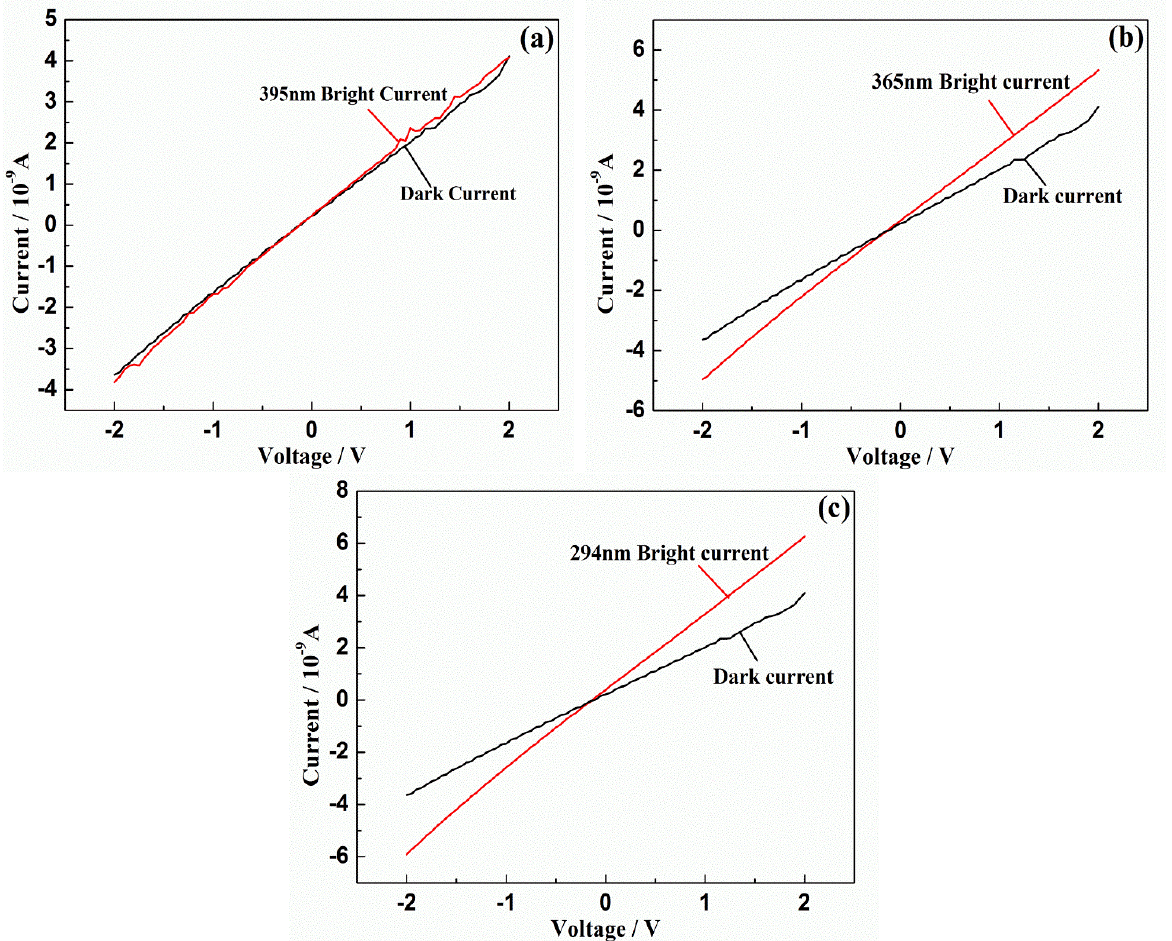
Figure 7. Photoconductivity instrument of La 0.9 Sr 0.1 TiO 3+δ : ( a ) 395 nm; ( b ) 365 nm; ( c ) 294